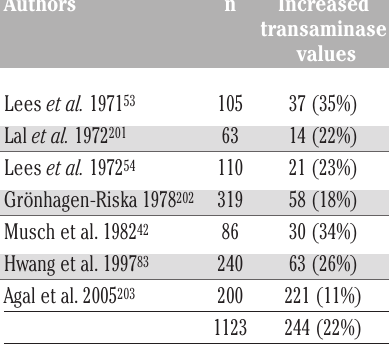
Table 4. Selected studies of adults with tuberculosis receiving INH and